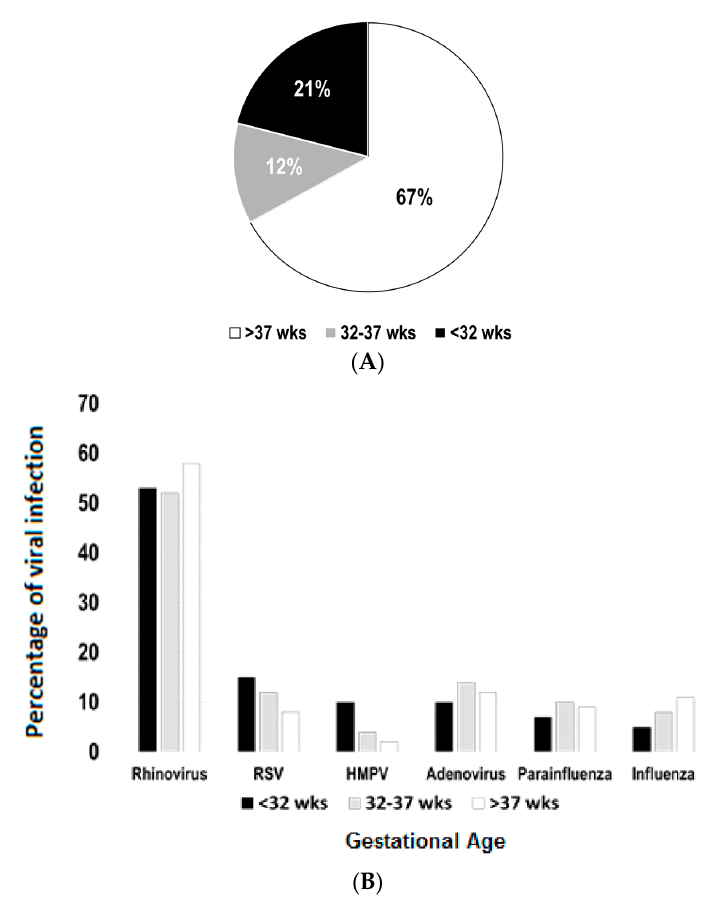
Figure 1. Epidemiology of viral respiratory infections according to gestational age (GA). ( A ) Sixty-seven percent of all viral-induced hospitalizations (n = 630) occurred in children born full-term (>37 weeks), 12% in preterm (32–37 weeks) and 21% in severely premature children (<32 weeks); ( B ) distribution of viral pathogens according to GA, presented as percentages of each virus (excluding cases of mixed infections; n = 69); RSV = respiratory syncytial virus; HMPV = human metapneumovirus.